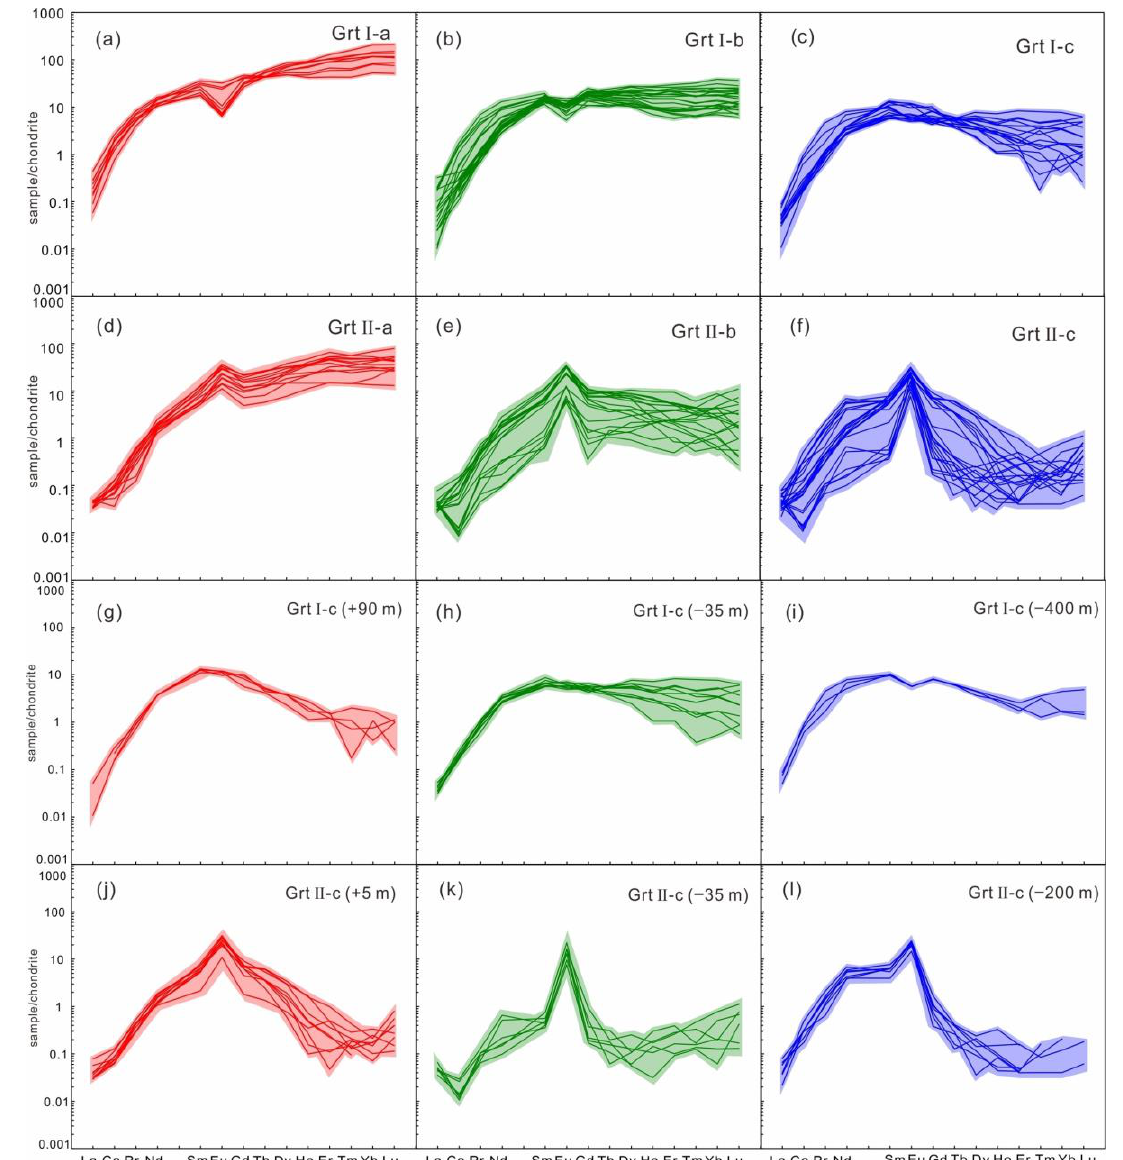
Figure 9. The standard REE patterns of Grt I and Grt II meteorites with varying elevations are divided into three sub-stages (a, b, c). The c-stage garnets (Grt I-c and Grt II-c) are selected for vertical comparison. ( a ) Grt I-a; ( b ) Grt I-b; ( c ) Grt I-c; ( d ) Grt II-a; ( e ) Grt II-b; ( f ) Grt II-c; ( g ) Grt I-c (+90 m); ( h ) Grt I-c ( − 35 m); ( i ) Grt I-c ( − 400 m); ( j ) Grt II-c (+5 m); ( k ) Grt II-c ( − 35 m); ( l ) Grt I-c ( − 200